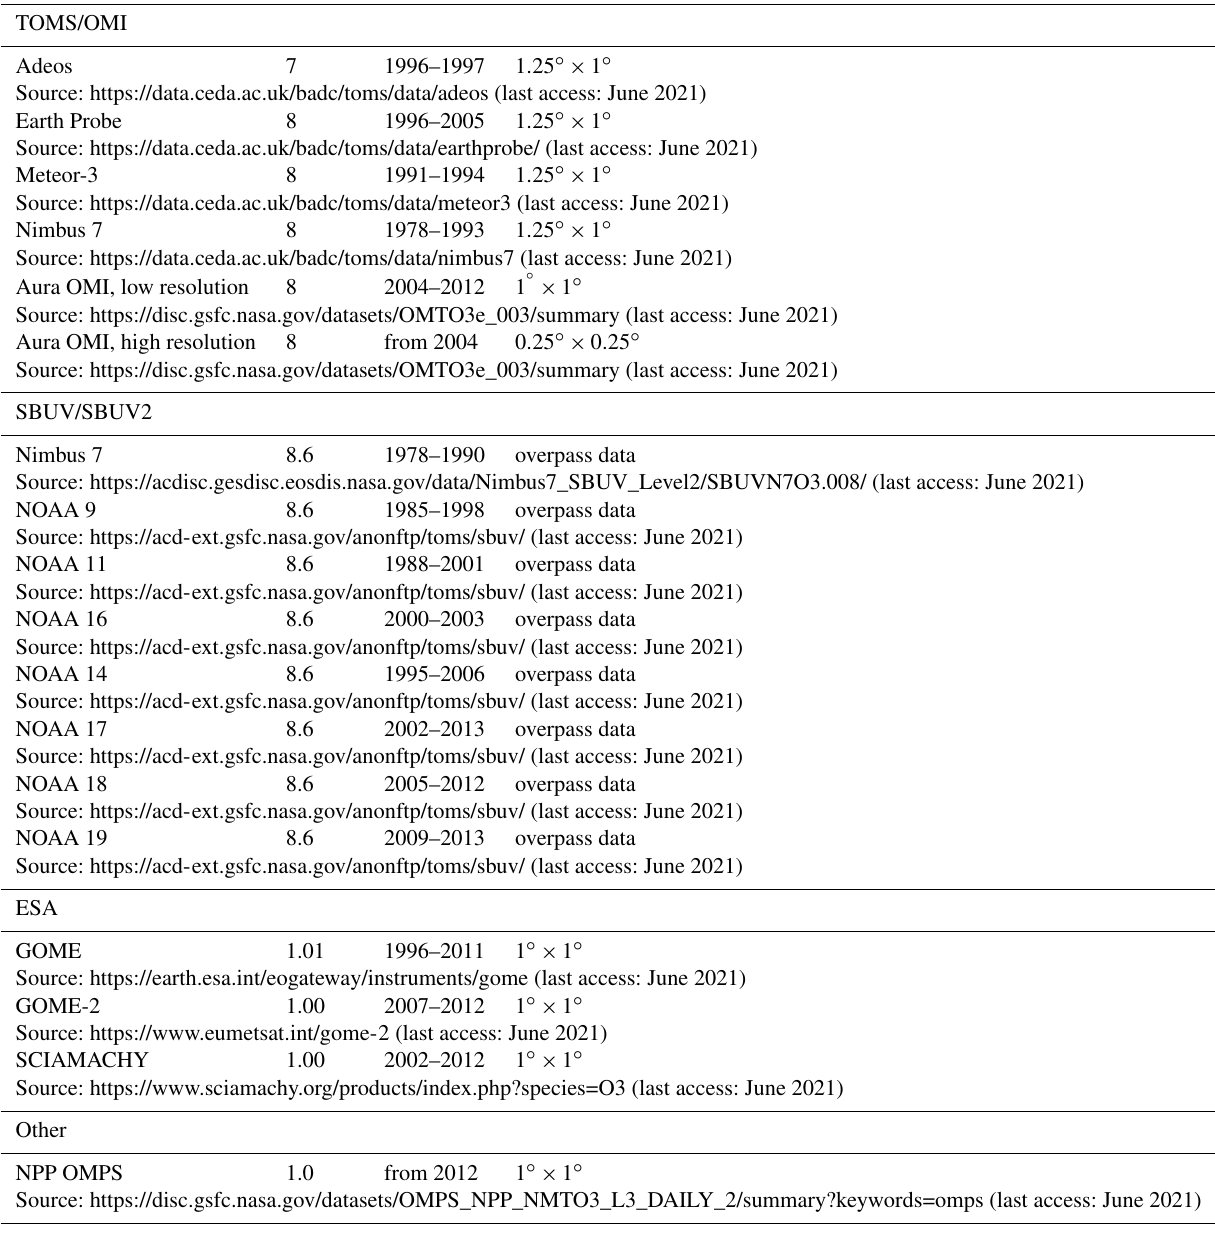
Table 1. The source data sets used to create version 3.4 of the NIWA-BS TCO database. Data